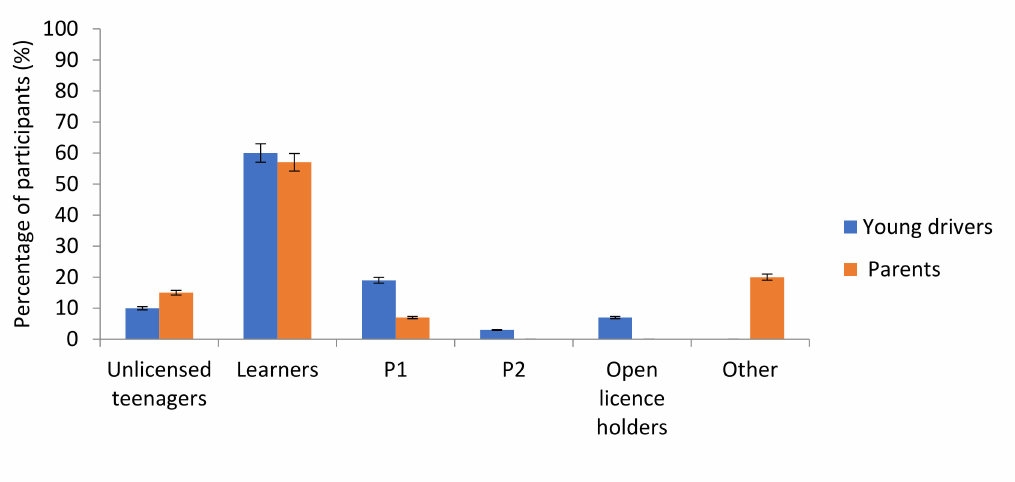
Figure 3. Percentage of young driver and parent responses indicating the target group that should be trained using a driving